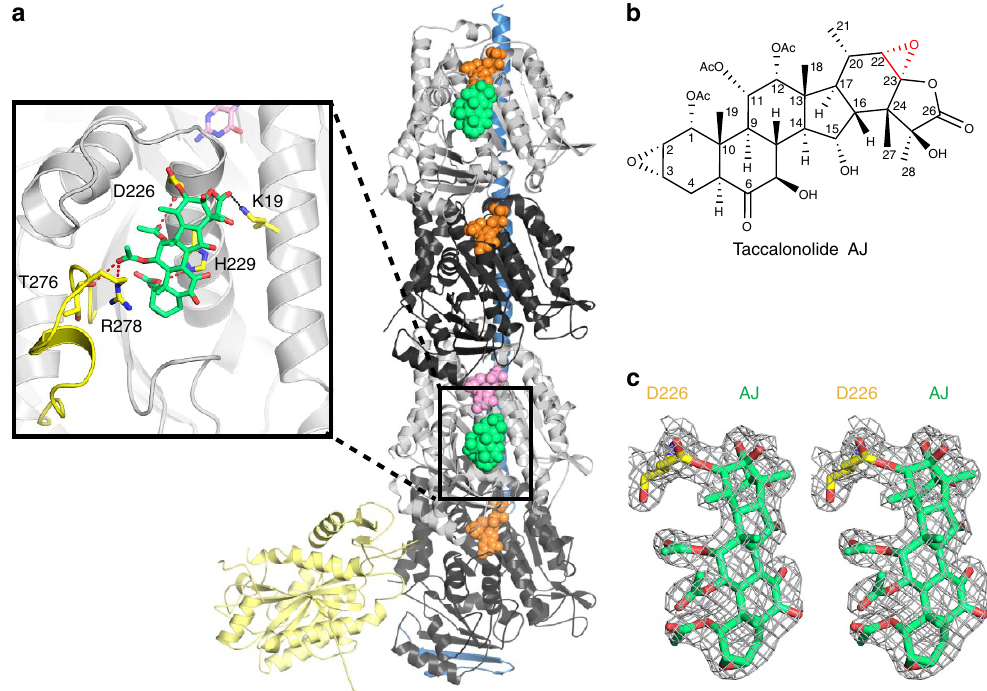
Figure 2 | AJ covalent binding to b -tubulin. ( a ) Overall structure of the complex crystallized. The RB3-SLD is coloured blue; TTL, light yellow; a -tubulin, black; b -tubulin, grey; GTP, orange; GDP, pink and AJ, green. The details of AJ binding are enlarged and the b M-loop is highlighted in yellow. ( b ) Chemical structure of taccalonolide AJ. The epoxide group between C22 and C23 is highlighted in red. ( c ) Stereo view of the Fo–Fc omit map (contoured at 3 s ) of AJ and the side chain of b D226, clearly showing the covalent bond between